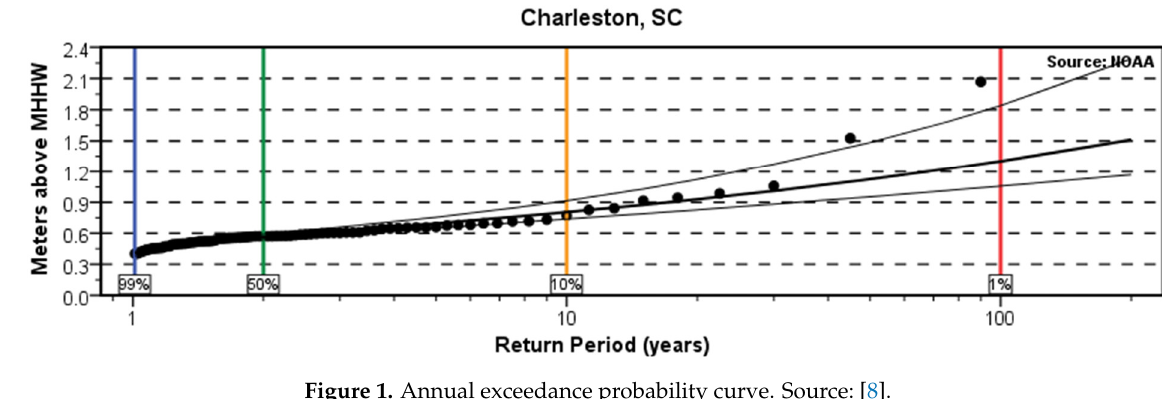
Figure 1. Annual exceedance probability curve. Source: [8].